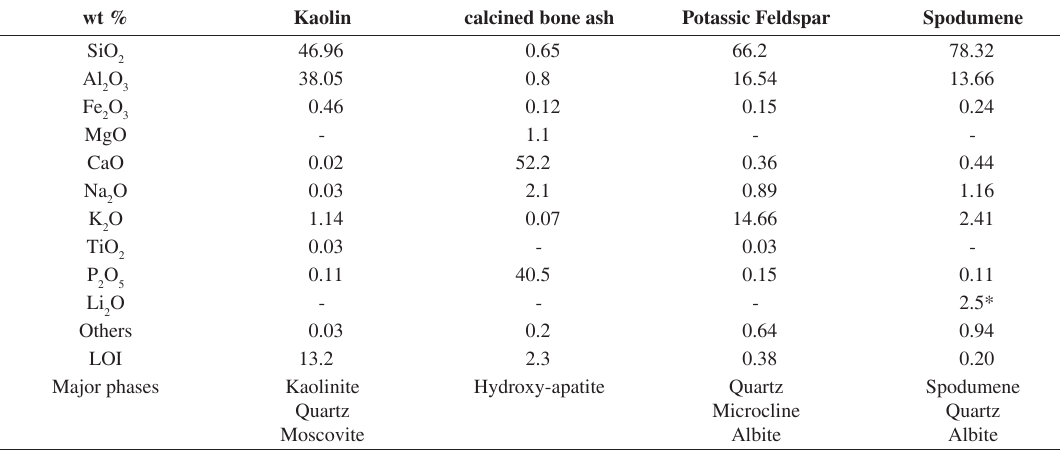
*analysis by atomic absorption.